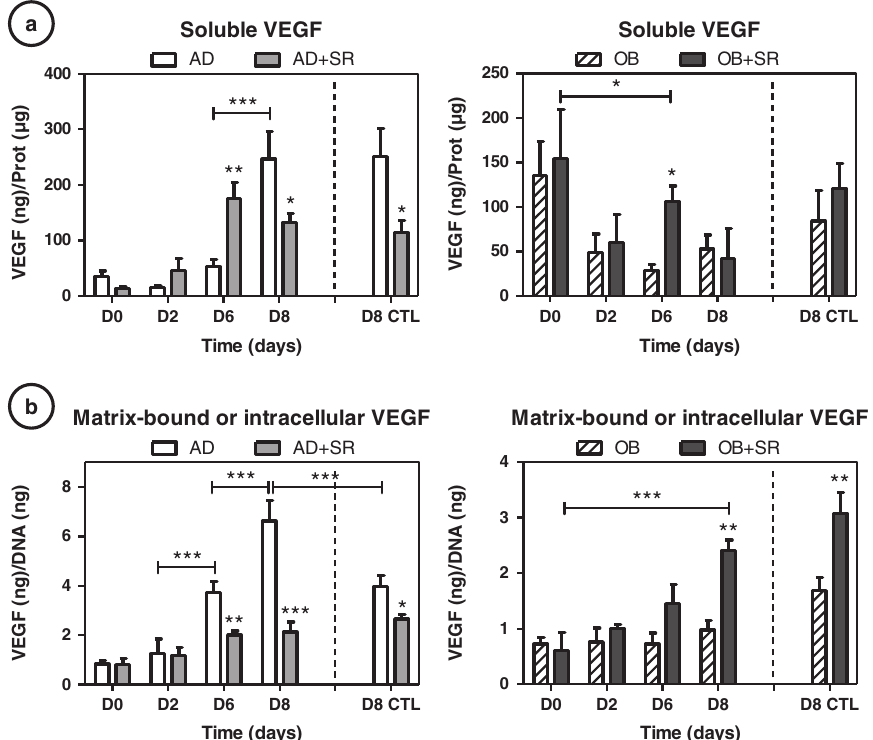
Fig. 4 Differential regulation of cell-associated and soluble VEGF by strontium: ELISA of VEGF protein was performed at days 2, 6 and 8 on culture supernatants to quantify soluble VEGF proteins a , normalized by total DNA as well as in cell/matrix lysates to quantify matrix-bound or cell-associated VEGF b , normalized by total proteins. Day 8 of control static condition corresponds to the D8 CTL data. Error bars represent S.E. M. * p < 0.05, ** p < 0.01 and *** p < 0.001 compared to media without strontium, or compared to conditions indicated by the horizontal bars ( N = 3 independent experiments). AD: adipogenic, OB: osteogenic, SR: